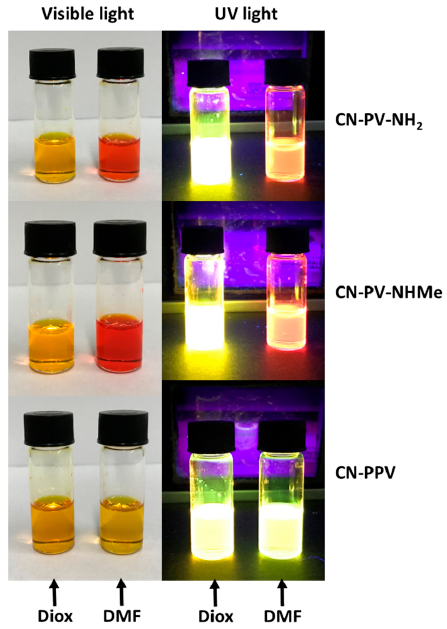
Figure 2. Precursor CN-PV-NH 2 , fluorophore CN-PV-NHMe and polymer CN-PPV solution (10% w / w ) in dioxane ( left ) and DMF ( right ) in natural light ( left column ) and under 375 nm UV light ( right column ). Molecules 2018 , 23 , x FOR PEER REVIEW